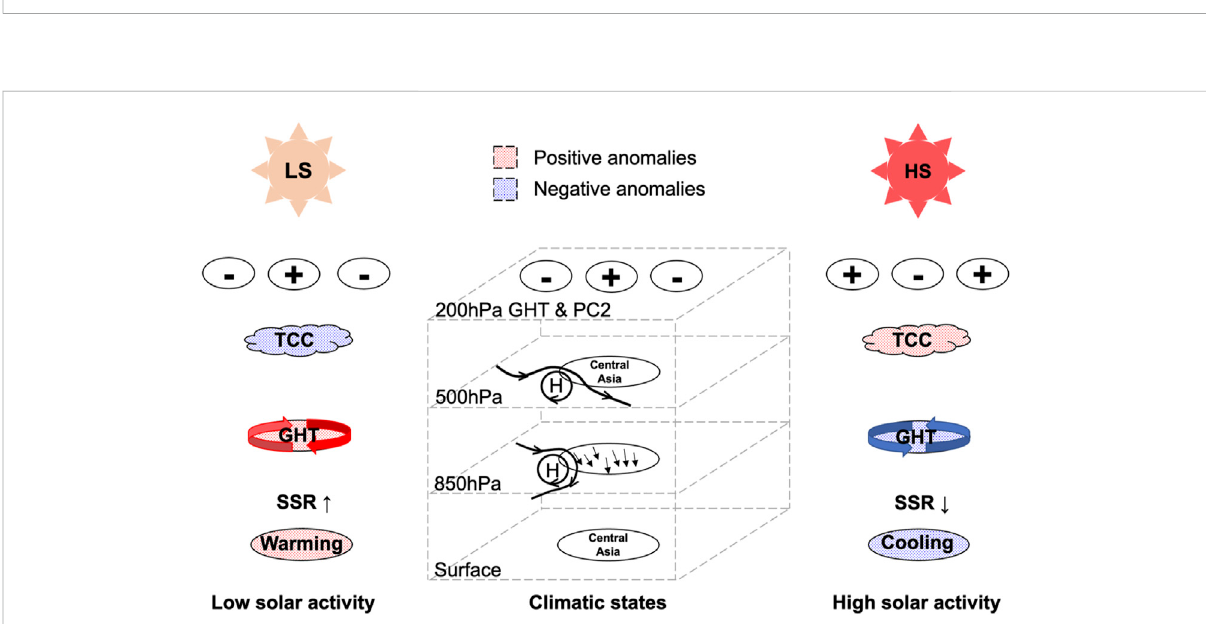
FIGURE 13 A schematic fi gure of the impact of solar activity on the summer temperature over Eurasia. ‘ TCC ’ , ‘ SSR ’ , and ‘ H ’ represent the total cloud cover, surface net solar radiation, and the high-pressure center, respectively. The black arrows in the middle panel show the north-westerly wind. Positive (Negative) anomalies are marked by red (blue) dots. The blue (red) widened vectors show the cyclonic (anti-cyclonic)